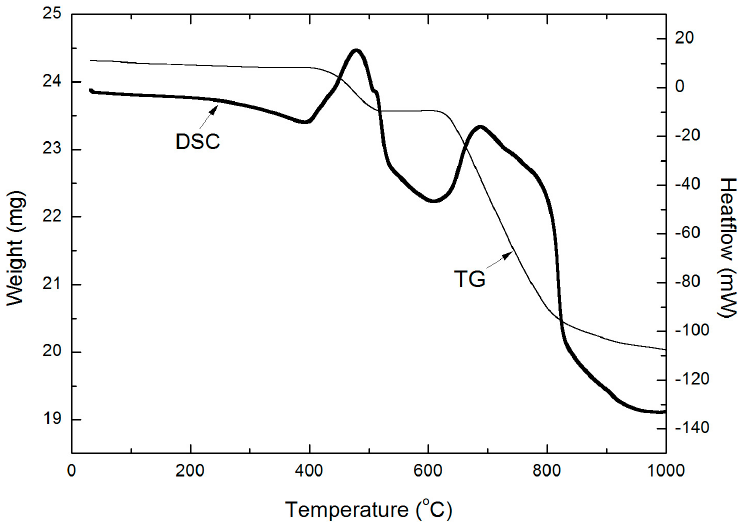
Figure 2. Thermogravimetric Analysis (TG) and differential scanning calorimetry (DSC) curves of zinc sulfide concentrate.